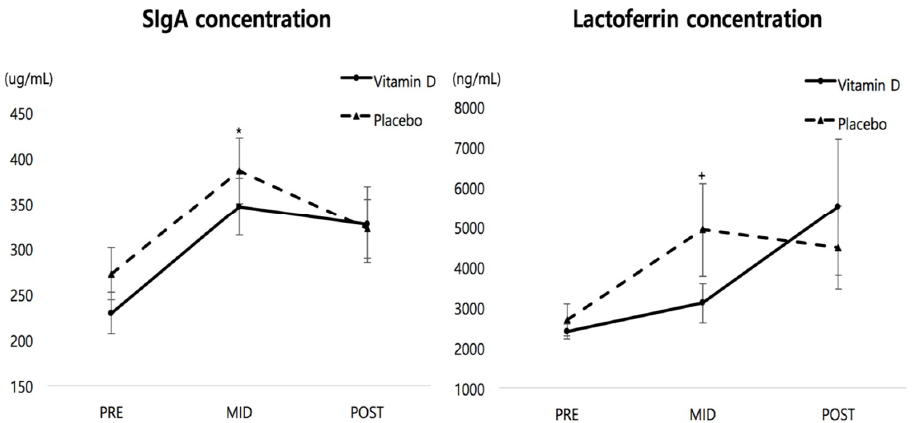
Figure 3. Changes in SIgA and lactoferrin concentrations. Note: * p < 0.05 indicates that SIgA concentration increased in both groups from pre- to mid -tests, + p < 0.05 indicates that lactoferrin concentration increased only in the placebo group from pre- to mid-tests.